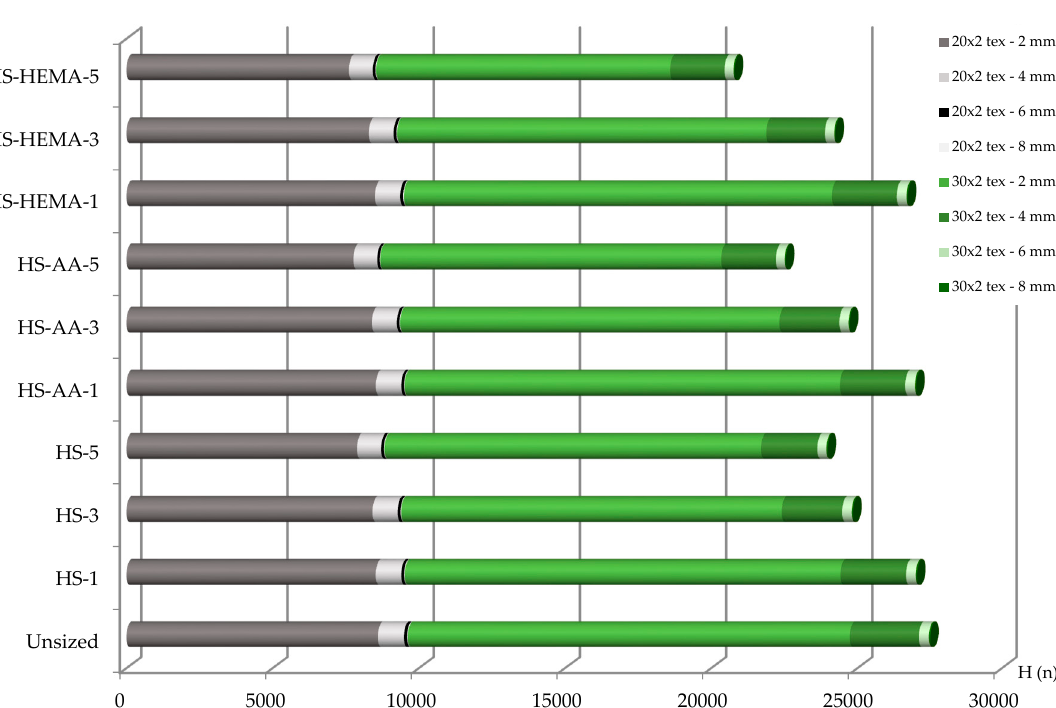
Figure 12. Hairiness of the plied yarn in the sizing process.